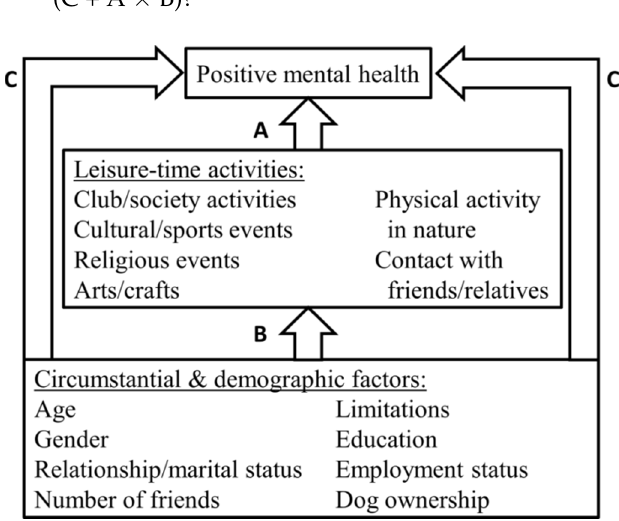
Figure 1. Conceptual model to assess the research questions 1–3.